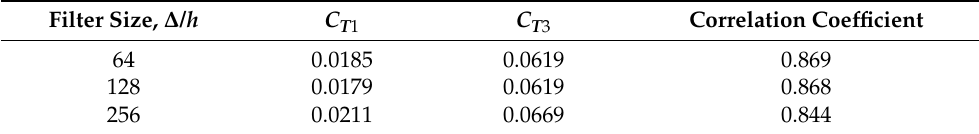
Table 5. Coefficients in the simplified model (8) without C T 2